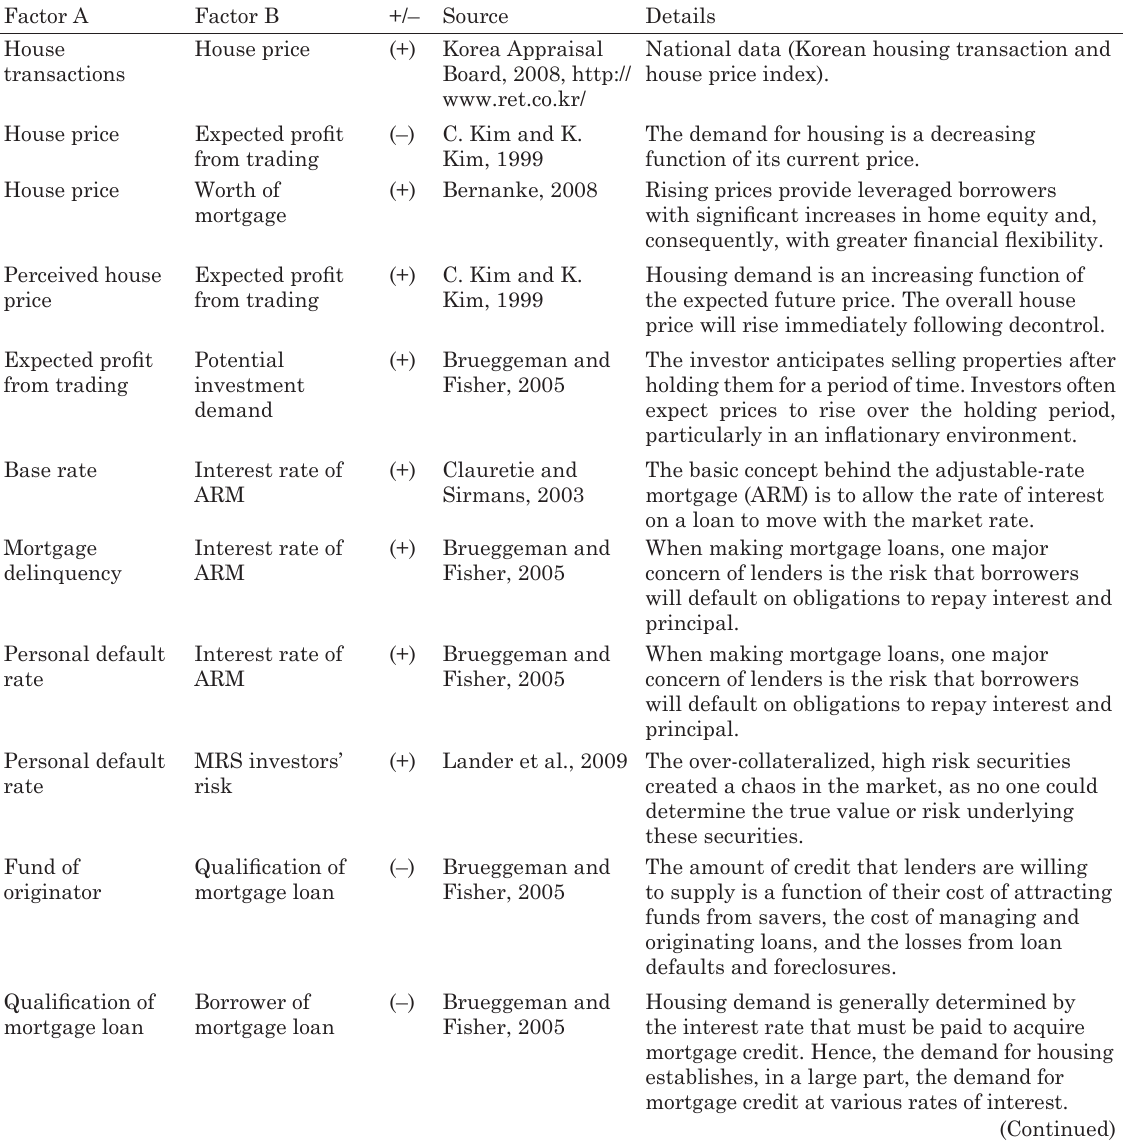
table 2. Relationship between influence